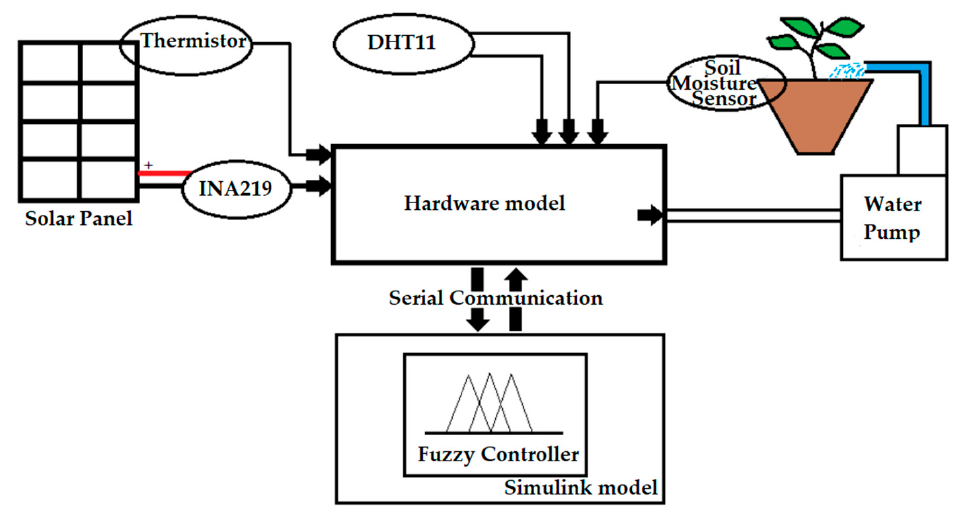
Figure 16. Block diagram of the control system.